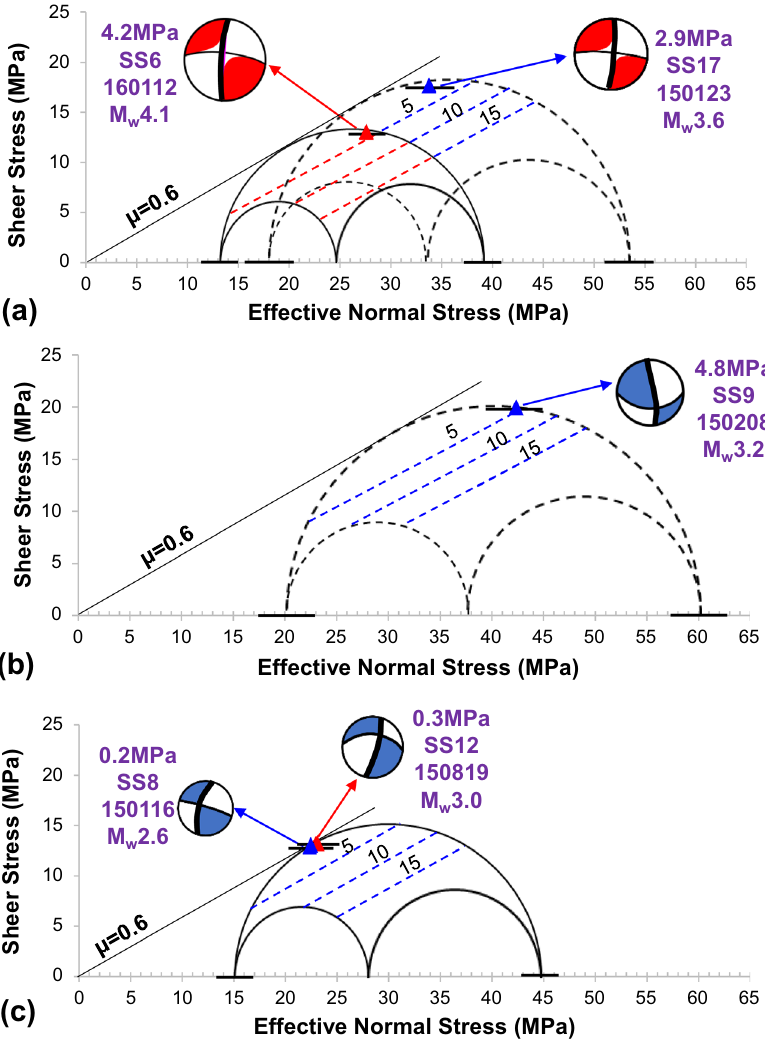
Figure 2. ( a–c ) Mohr circles showing the original stress state of seismogenic faults for five known cases. The contours (units of MPa) within the Mohr circles indicate the increase in pore pressure required to reactivate the associated faults 13,14 . The short black lines in the axis denote the errors of the calculated normal